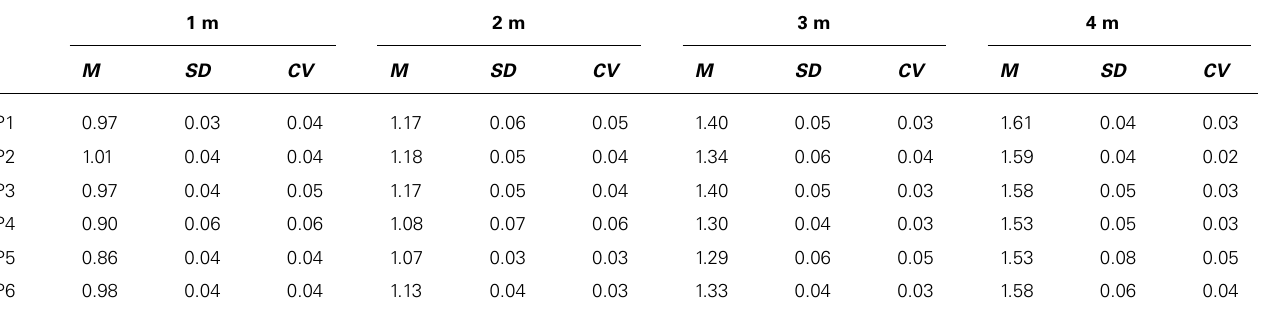
Table 1 | Mean, standard deviations (SD), and coefficients of variation (CV) for putterhead velocity (V 2 c ms − 1 ) at ball impact for each participant (P) and putt distance. 1 m 2 m 3